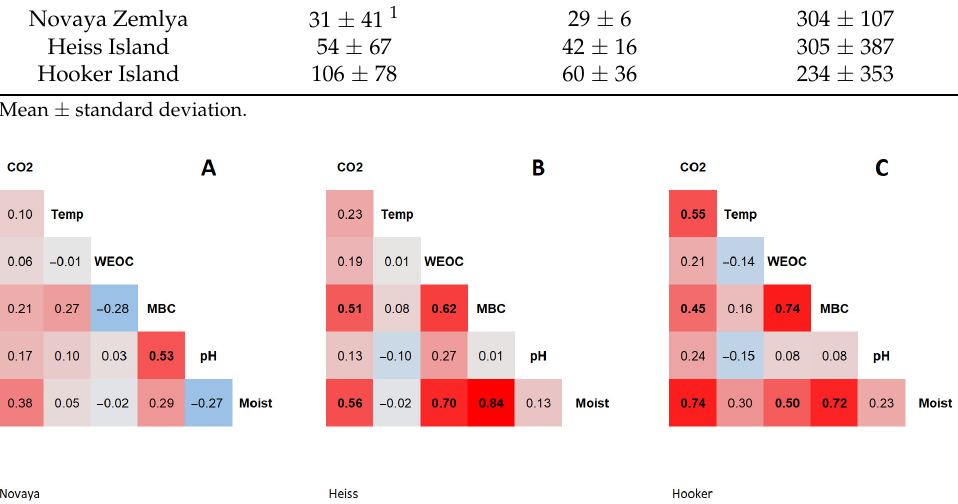
Table 2. Mean values of the CO 2 emission, WEOC and MBC in soil samples. Island